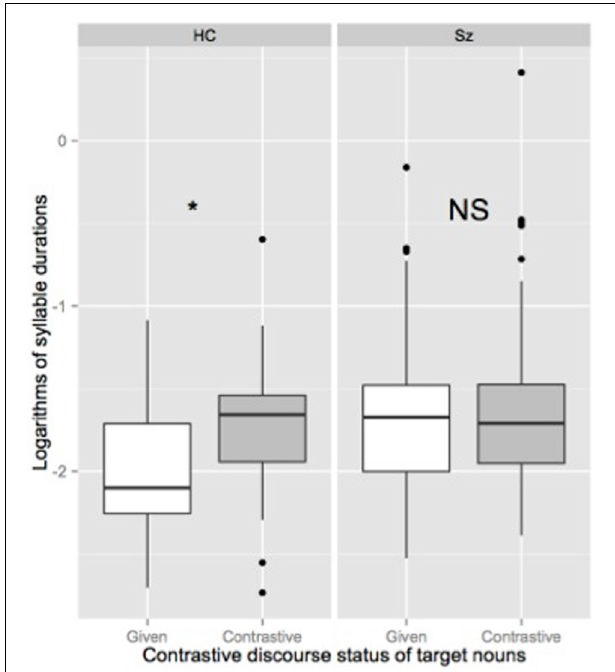
FIGURE 5 | Boxplot of logarithms of f0 maxima associated to the last syllables of target nouns produced by healthy controlsparticipants (HC)